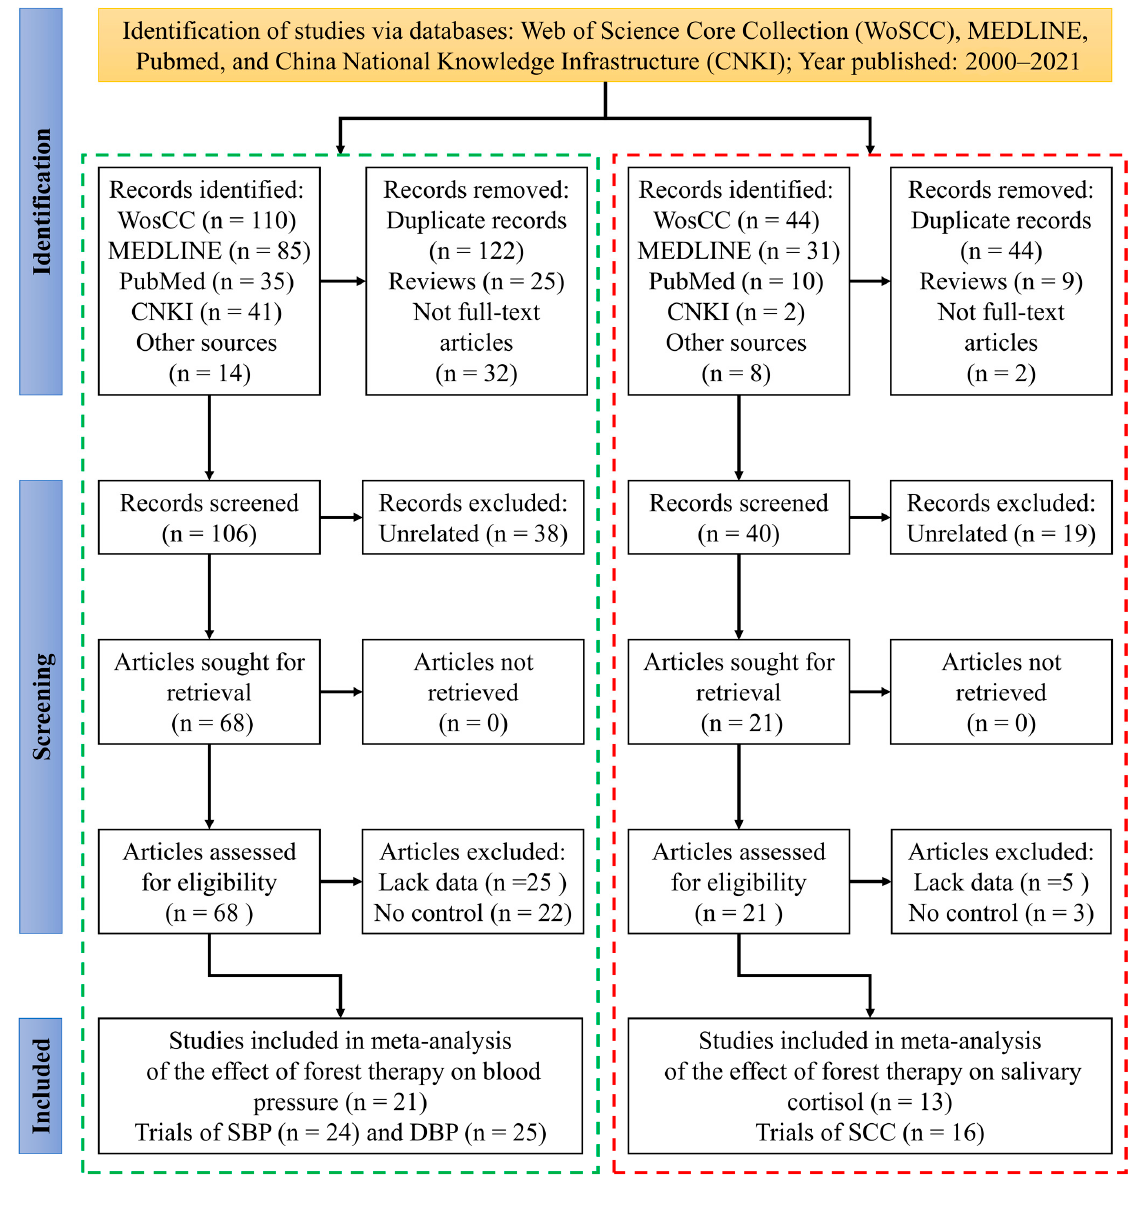
Figure 1. Flow diagram of the study selection process for the present study. This flow diagram